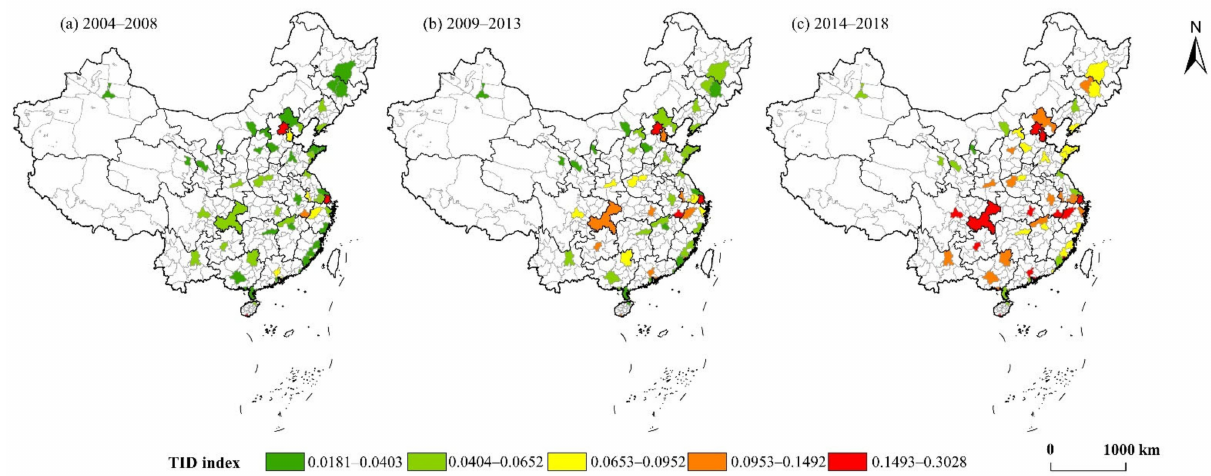
Figure 5. Spatial distribution of TID index of major tourist cities in China from 2004 to